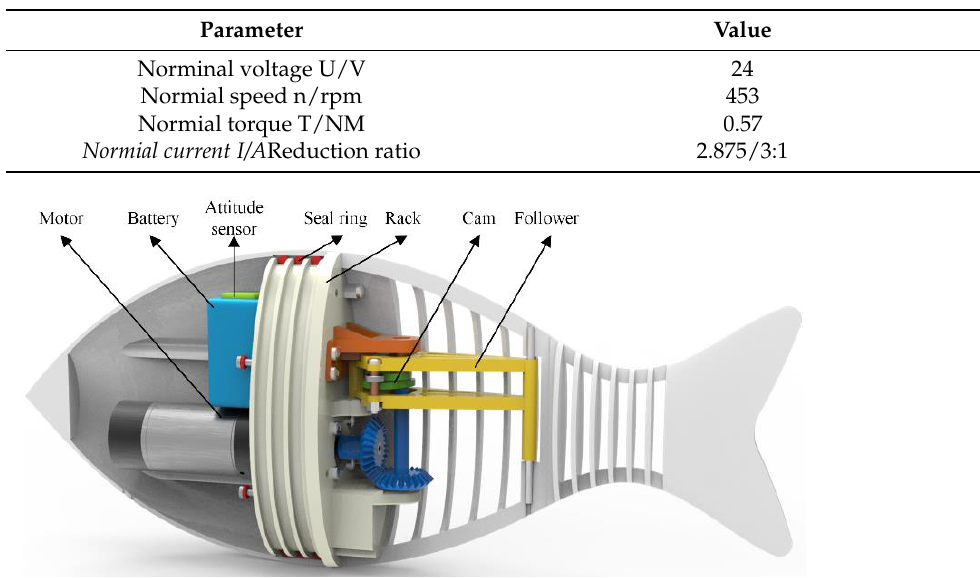
Table 2. Parameters of the DCX 32L motor.